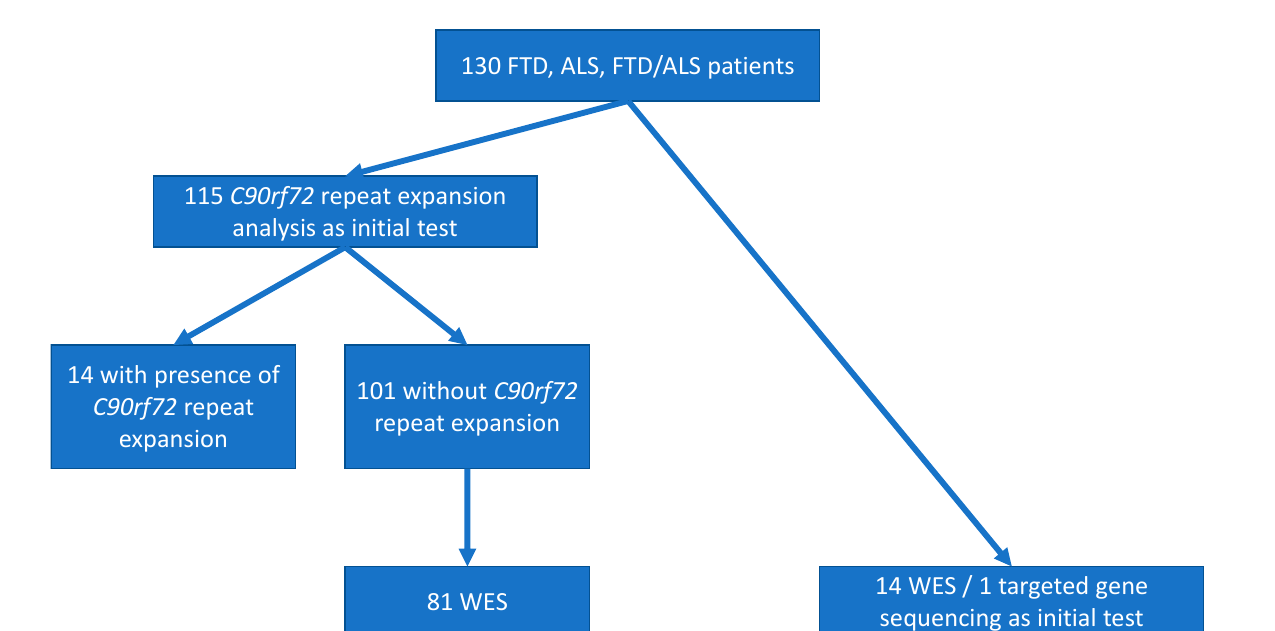
Figure 1. Flow chart of the genetic characterization of FTD and/or ALS patients in the cohort we analyzed. Most (115 out of the 130) patients were analyzed by C9orf72 repeat expansion analysis as the initial test. Subsequently, 81 of the 101 C9orf72 repeat expansion negative patients were analyzed by WES (whole exome sequencing). For 14 patients, WES was chosen as the initial test, and for 1 (with a pathogenic variant in the VCP gene), targeted gene sequencing was performed initially due to clinical picture and family history highly suggestive of inclusion body myopathy, Paget’s disease and FTD [23].